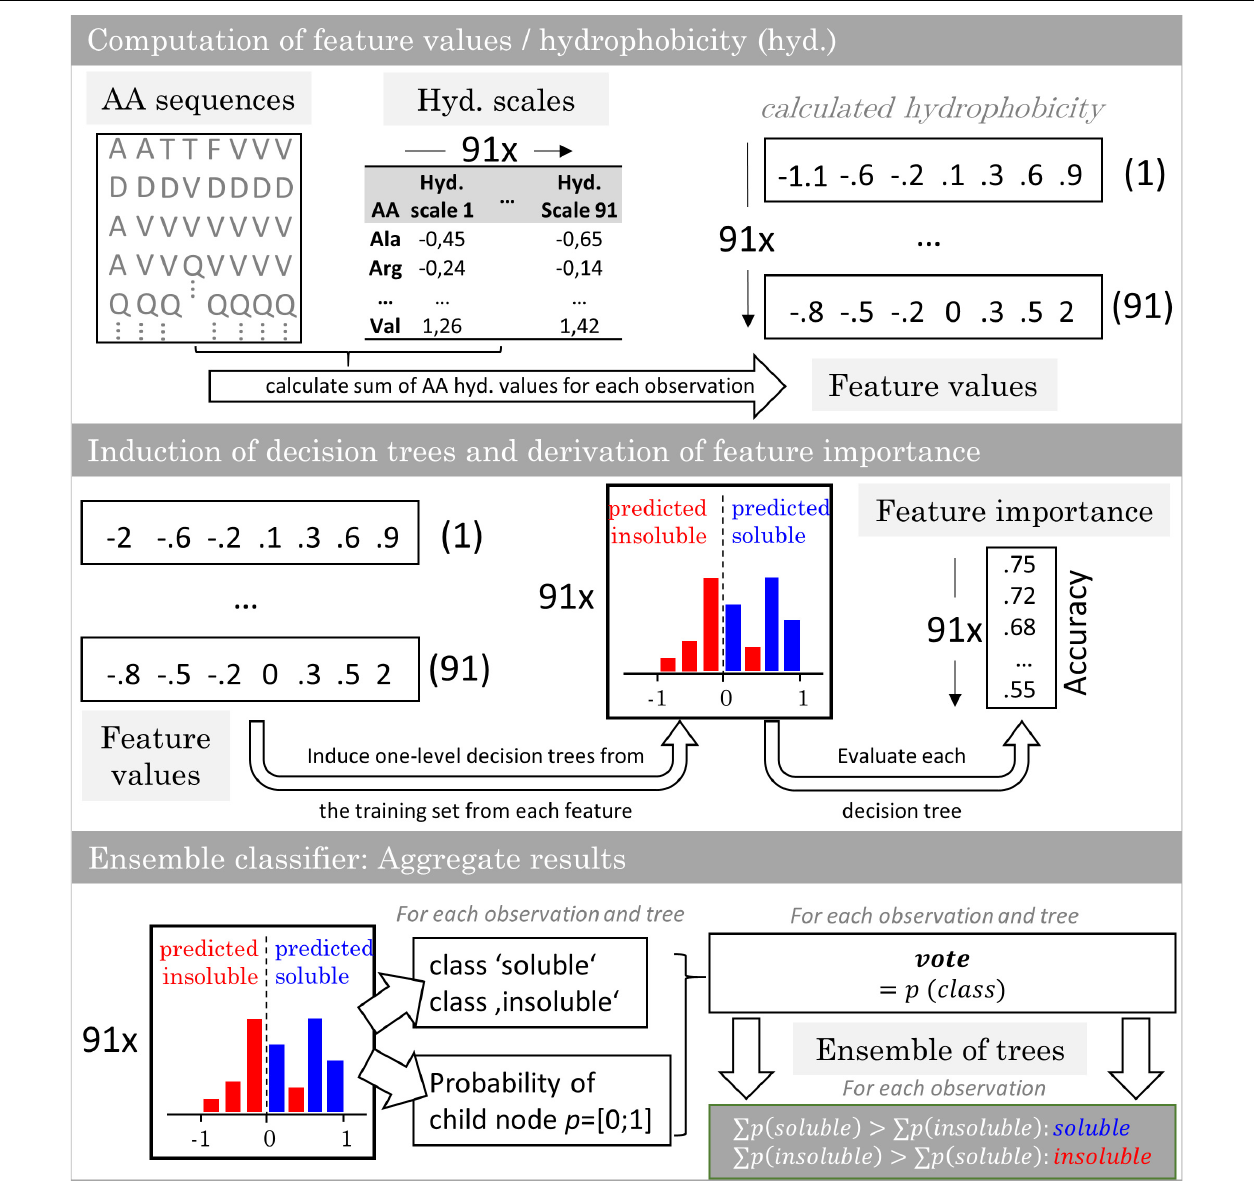
FIGURE 1 | Workflow of the ensemble vote classifier. The ensemble vote classifier is constructed by computation of feature values from virus-like particle sequence data and 91 hydrophobicity scales. With the training set features, one-level decision trees are induced. The individual decision trees’ accuracy in predicting the training set is defined as the feature importance. In the ensemble model, each decision tree contributes a solubility decision with associated probability. The results are aggregated and the most probable class is chosen by the